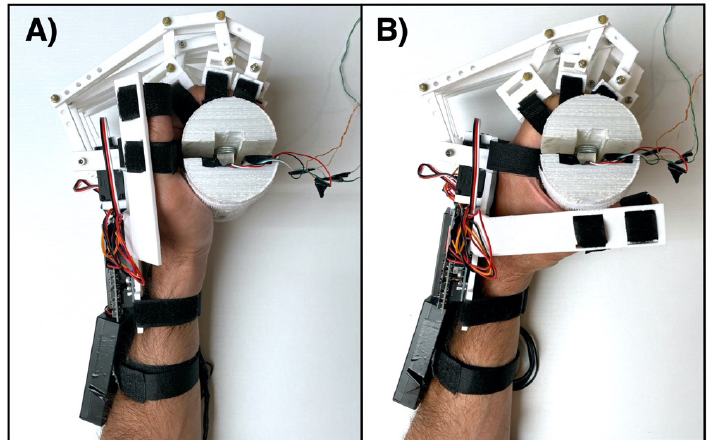
Figure 12. Power grasp test by means of the sensorized handlebar: ( A ) test with the thumb in the adduction position (i.e., aligned to the fingers); ( B ) test with the thumb in the abduction position (i.e., in opposition to the fingers).